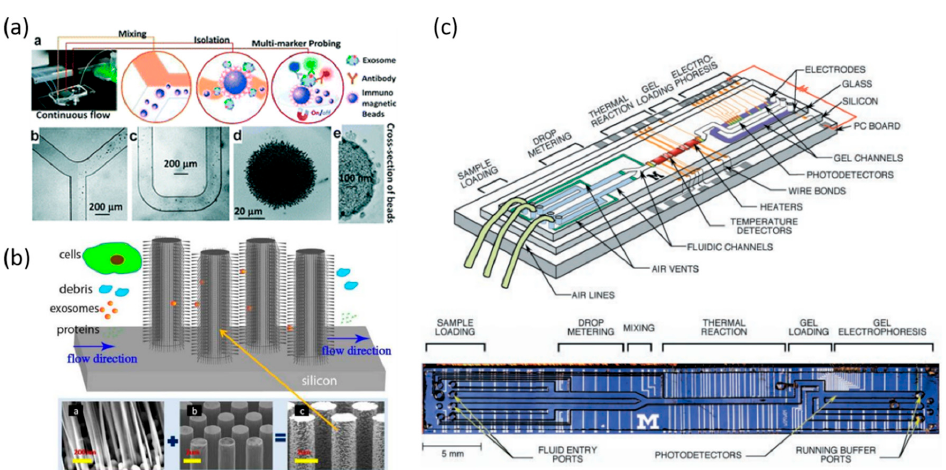
Figure 4. Microfluidic system for exosome and nucleic acid analysis. ( a ) Workflow of microfluidic chip for sample and particle mixing, isolation, and detection of exosomes. Microscope images of immunomagnetic beads for mixing and isolation of exosomes. Reprinted with permission from the authors of [51]; ( b ) A schematic of ciliated micropillar array for exosome separation. While cells are depleted before entering the region, exosomes are highly enriched by trapping within nanowires. Reprinted with permission from the authors of [100]; ( c ) An integrated DNA microfluidic analysis device. (Top) Two liquid samples and electrophoresis gel are presented. (Bottom) Optical micrograph of the device from above. Reprinted with permission from the authors of [111].